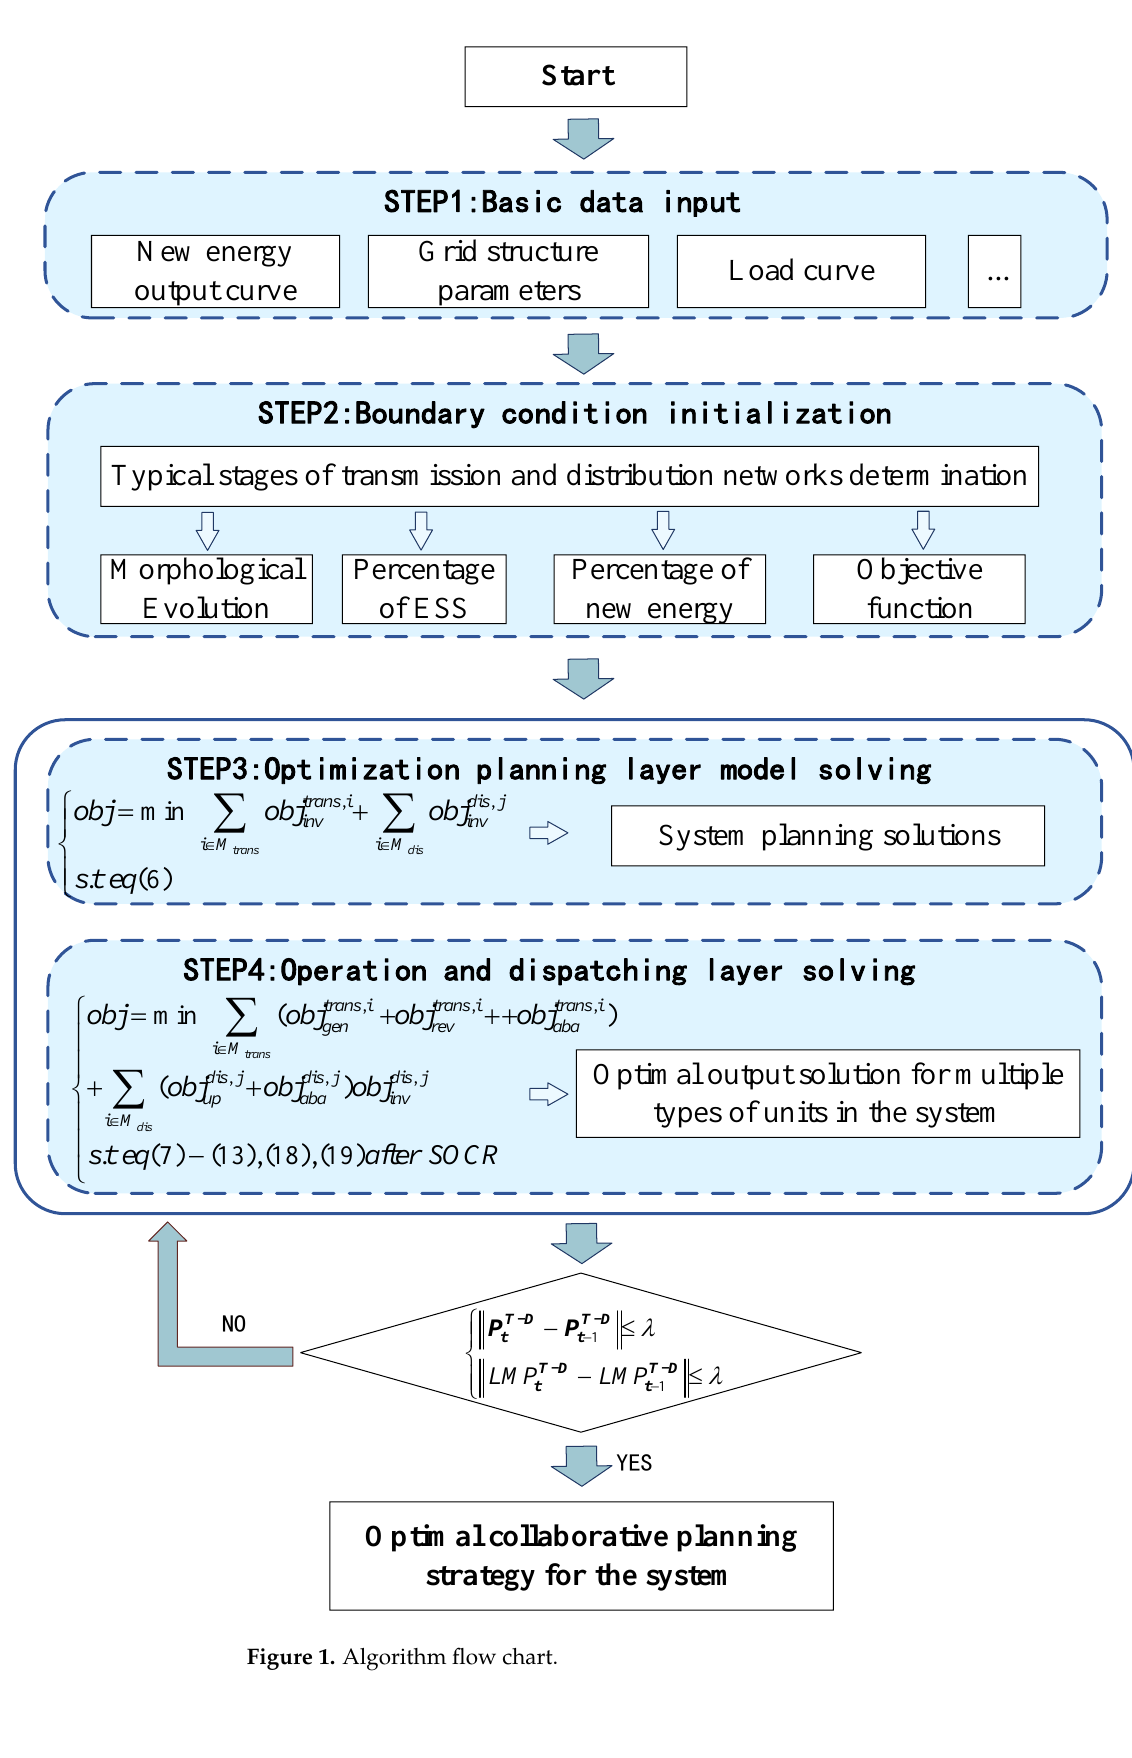
Figure 1. Algorithm flow chart.